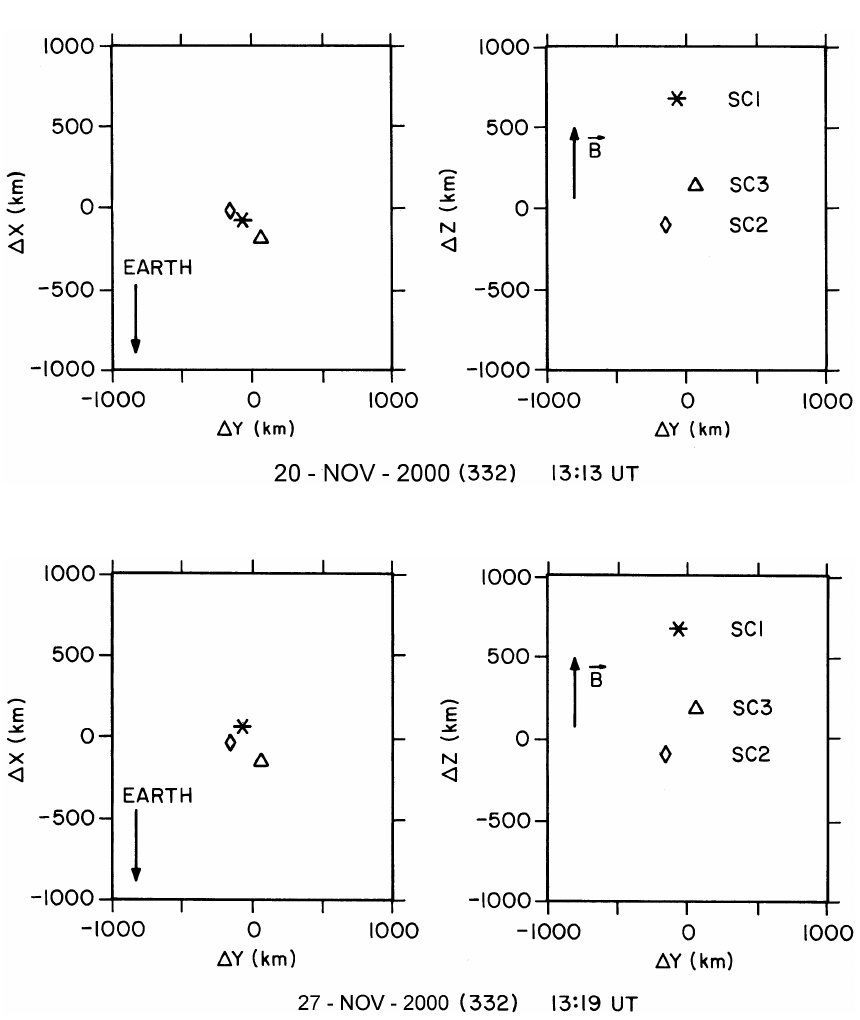
Fig. 9. The relative locations of space- craft SC1, SC2 and SC3 in magnetic field-aligned coordinates at 13:19UT on 27 November 2000, using the Tsy- ganenko model for the Earth’s magnetic field (Tsyganenko, 1989). At this time, the spacecraft were slightly north of the magnetic equator. Note that the relative separation in the 1X − 1Y plane, trans- verse to the magnetic field, is compara- ble to Fig.